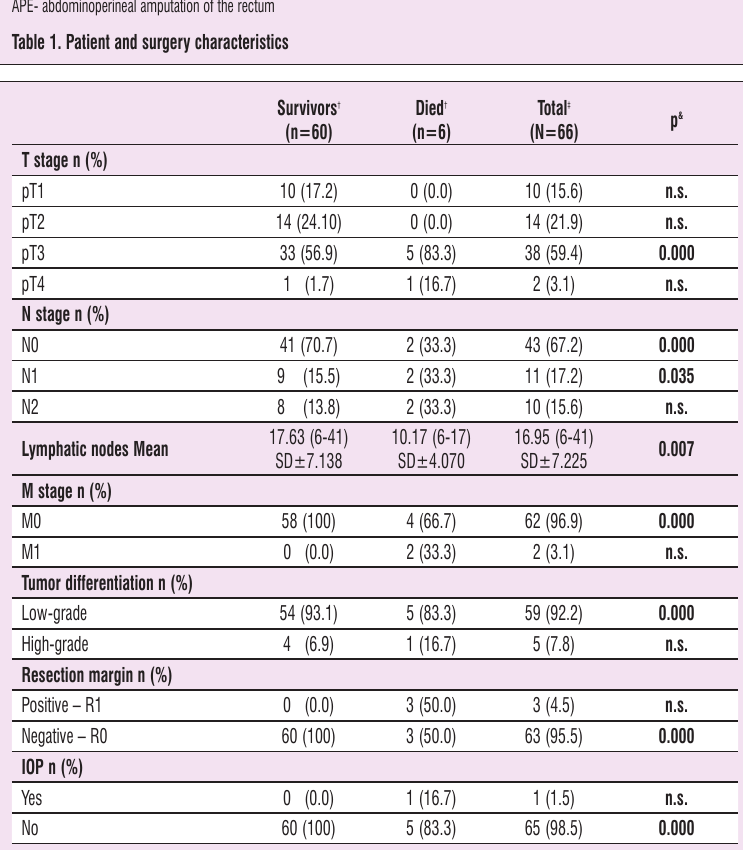
Table 2. Histopathological